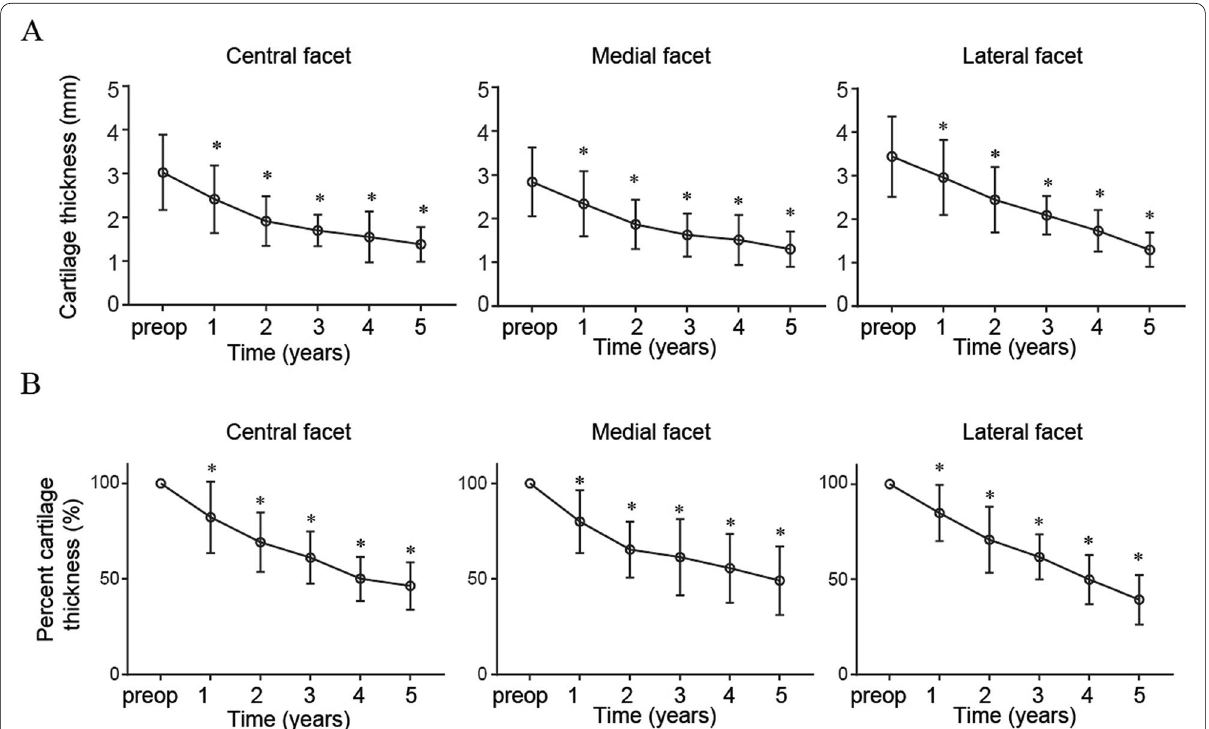
Fig. 2 Longitudinal analyses of the percent cartilage thickness and cartilage thickness over a 5-year period. Longitudinal evaluation of changes in patellar cartilage thickness in patients undergoing non-patellar resurfacing total knee arthroplasty. * P < 0.05, versus preoperative